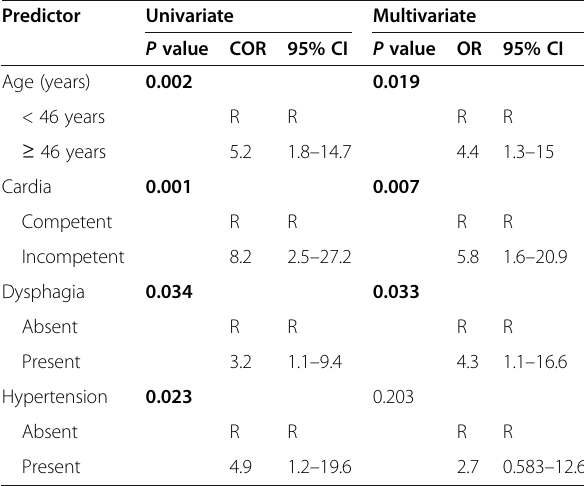
Table 3 Predictors of the likelihood of low-grade EE vs absent